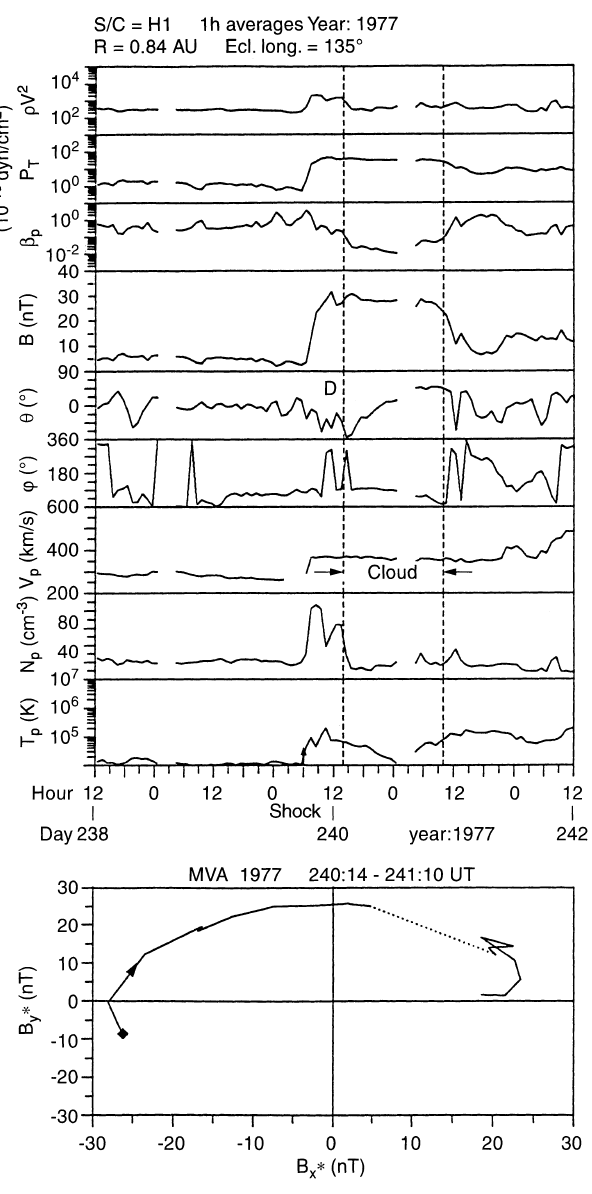
Fig. 6. A MC ( dashed lines ) of type SWN observed with Helios 1 at 0.9 AU on days 363, 09 UT– 364, 14 UT in 1978, associated with a shock on day 362, 23 UT. The bottom panel shows the counter-clockwise rotation with (cid:255) B y -values in the plane of maximum variance. The cloud’s axis direction was (cid:117) (cid:136) 117 (cid:14) , (cid:104) (cid:136) (cid:255) 30 (cid:14) , the minimum variance direction was (cid:117) (cid:136) 230 (cid:14) , (cid:104) (cid:136) (cid:135) 47